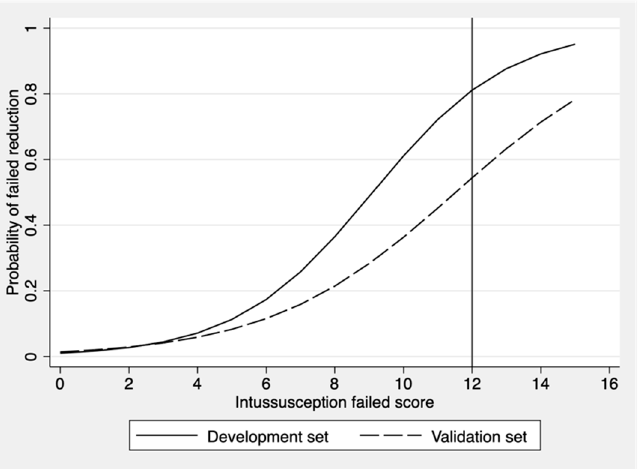
Figure 3. Score-predicted probability of failure of nonoperative reduction of intussusceptions between the developmental set and the validation sets with a cut point score of 12.